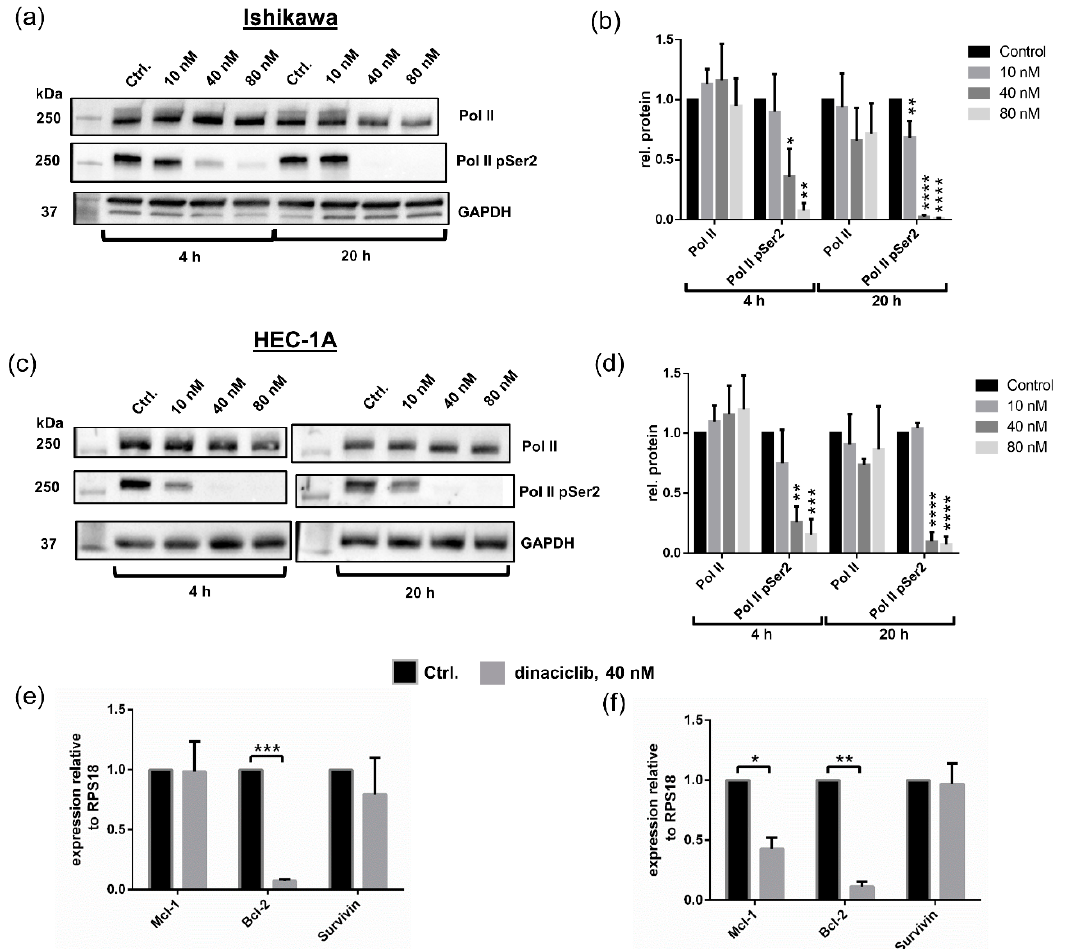
Figure 5. Dinaciclib inhibits Polymerase II (Pol II) C -terminal domain (CTD) Ser2 phosphorylation and concomitantly reduces in Bcl-2 expression. ( a ) Immunoblots of Pol II and Pol II pSer2 in Ishikawa cells following 4 h and 20 h of treatment with dinaciclib and the vehicle control and ( b ) the corresponding densitometry data (normalised to Glyceraldehyde-3- phosphate dehydrogenase (GAPDH)). ( c ) Immunoblots of Pol II and Pol II pSer2 in HEC-1A cells following dinaciclib treatment and ( d ) the corresponding densitometry data. qPCR data from ( e ) Ishikawa and ( f ) HEC-1A samples showing Mcl-1, Bcl-2, and survivin mRNA levels following 40 nM dinaciclib treatment for 24 h. Transcript levels are normalised to the reference gene RPS18 and expressed relative to control samples. Statistical significance was calculated by ANOVA followed by Dunnett’s test. * p value < 0.05, ** p value < 0.01, *** p value < 0.001, **** p value <